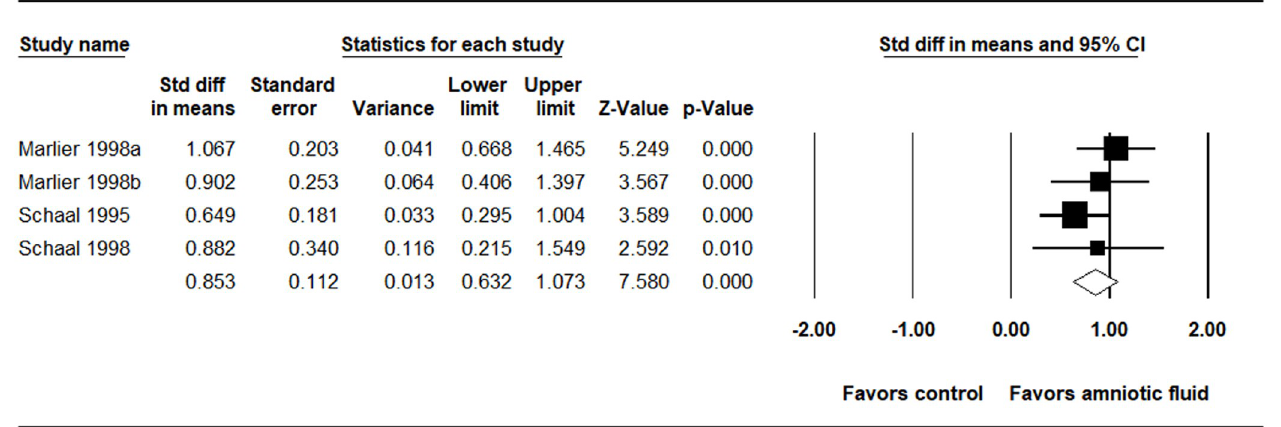
Fig 3. Forest plot of meta-analysis in the second group of studies. Diamonds represent the overall effect sizes, with squares representing individual studies. The size of the squares represent the weights assigned to each study.